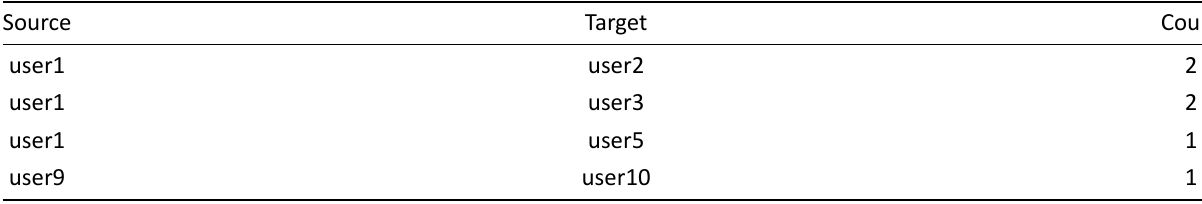
Table 4. Merged edges for each user